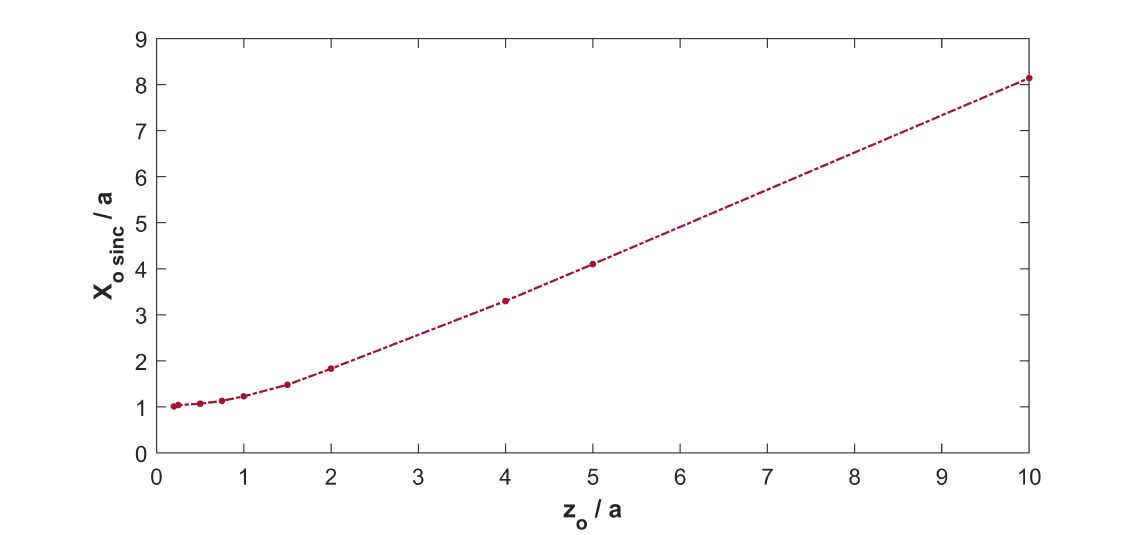
Figure A4. Diagram of X osinc / a in terms of z o / a